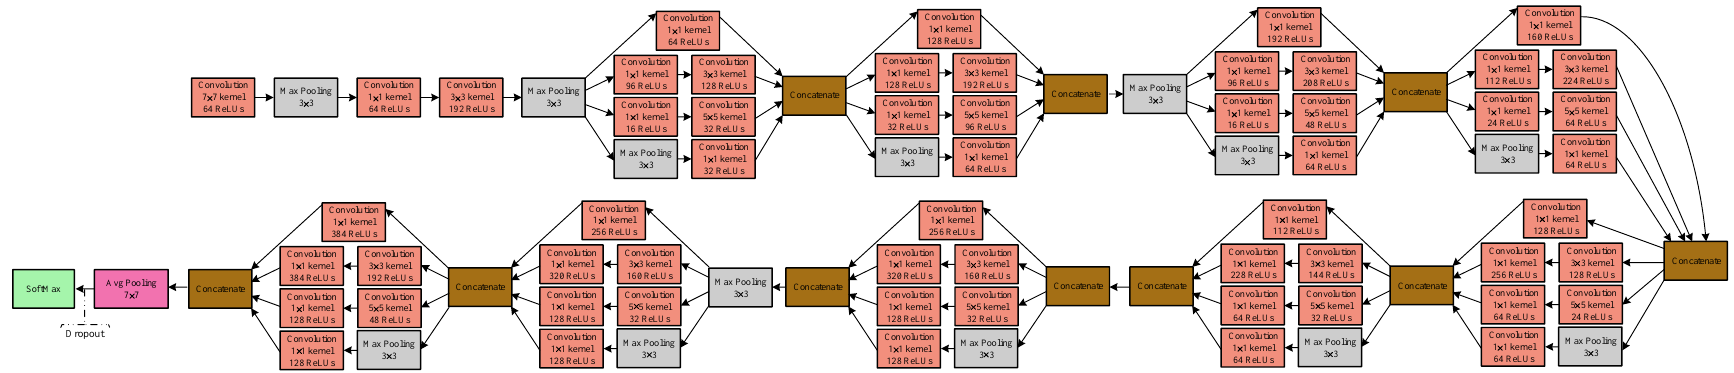
Figure 3. The GoogLeNet architecture used in this paper. In the inception module, the convolutions with different sizes can make the network process the input features at different